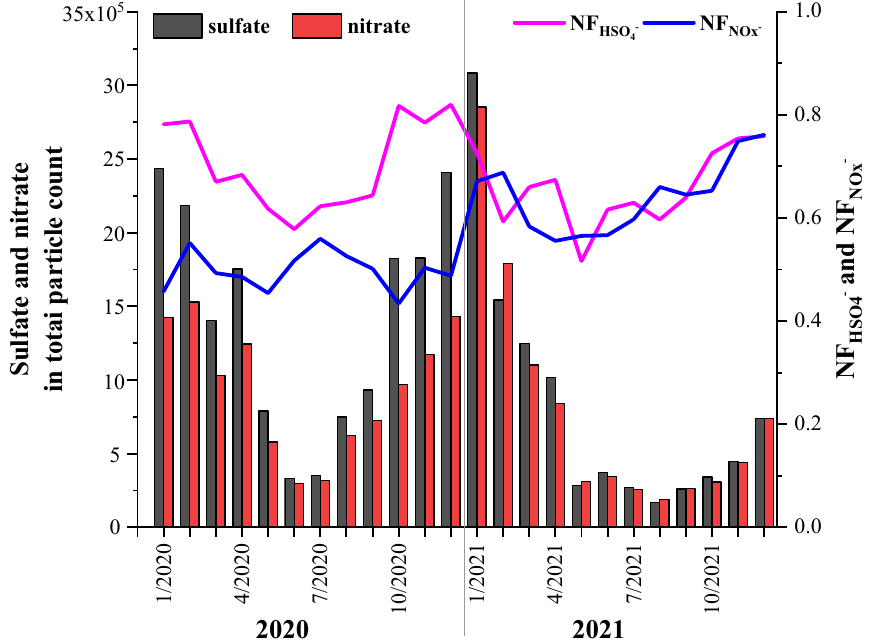
Figure 8. Change trends of sulfate- and nitrate-containing particulate matter and their proportions of the total particulate matter from 2020 to 2021. The bar graph shows the number of particles and the line graph shows the proportions.